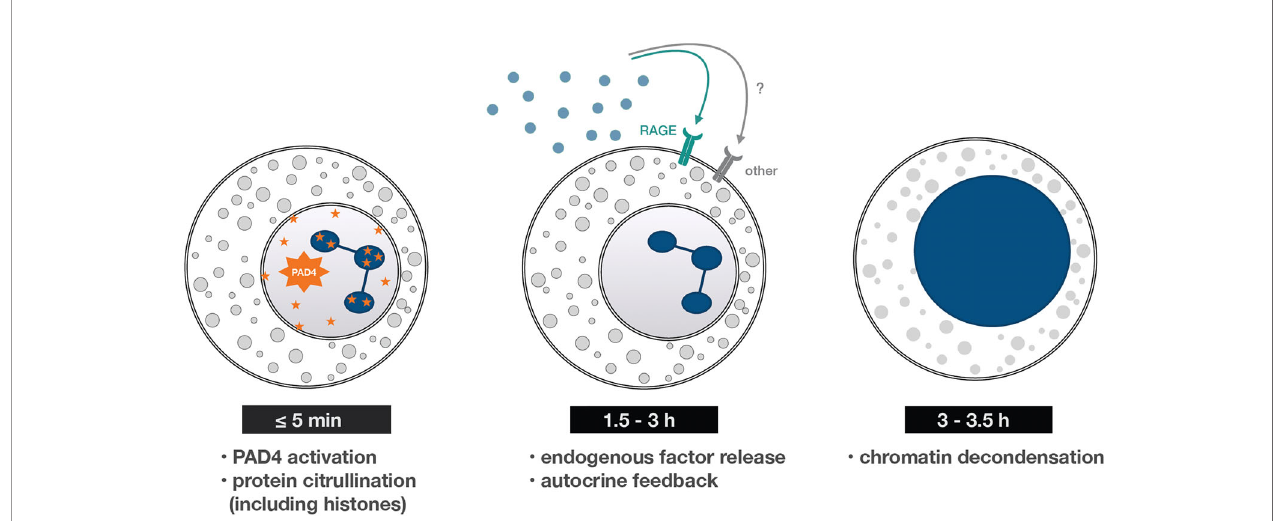
FIGURE 7 | Early and late processes underlying NET formation . A summary of the fi ndings reported herein. Within minutes of neutrophil stimulation, PAD4- dependent protein citrullination occurs – an early cellular process needed for NET formation. It then takes some 90-180 min for neutrophils to release RAGE ligands (and perhaps other molecules) that both condition the cells to generate NETs and trigger the later stages of the process. One such late stage is chromatin decondensation, which occurs some 3-3.5 h post-stimulation, and is quickly followed by chromatin extrusion into the extracellular